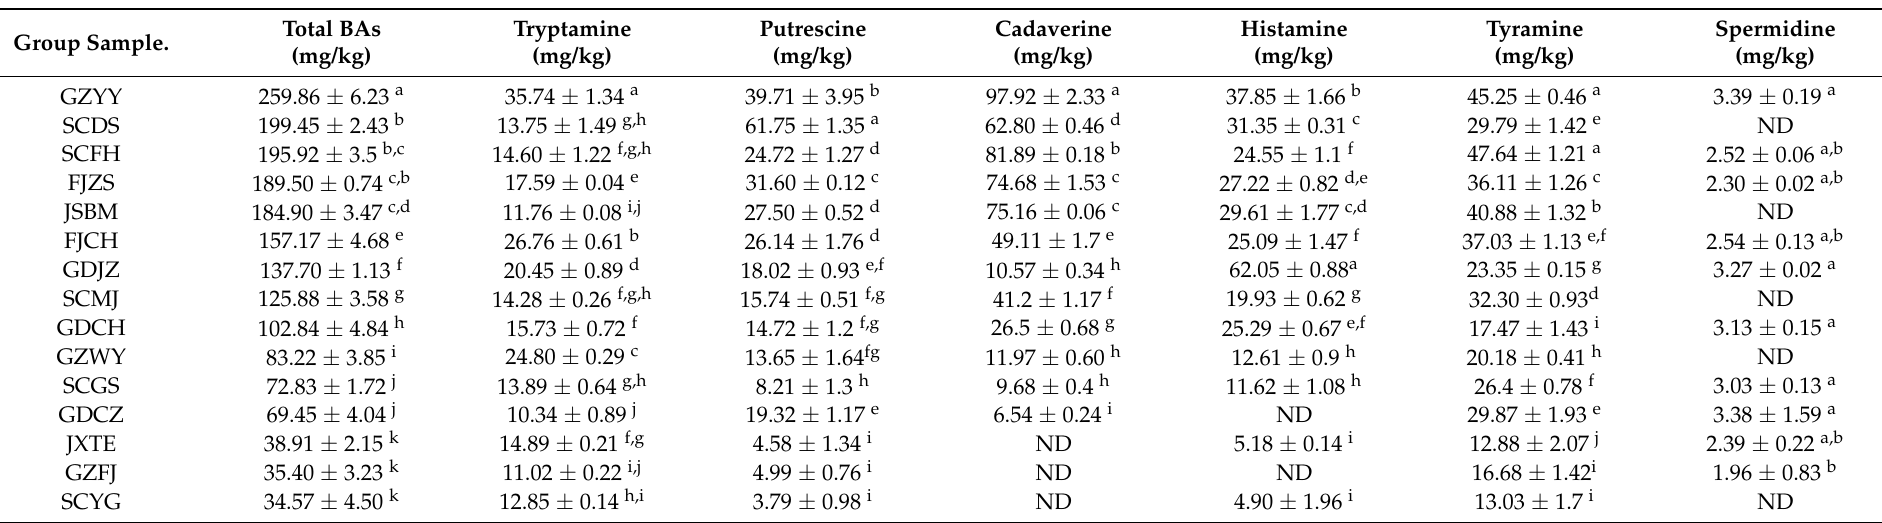
Table 3. Contents of BAs in FM samples. Data are presented as mean ± SDs of three replicates; ND means “not detected”. Different letters (a, b, c, etc.) indicate significantly different means at p < 0.05. Group